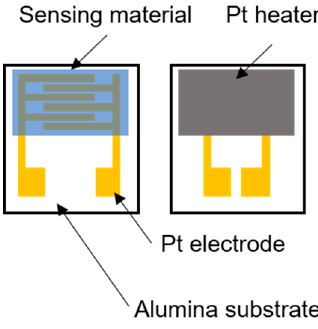
Figure 1. The schematic illustration of the sensor device.